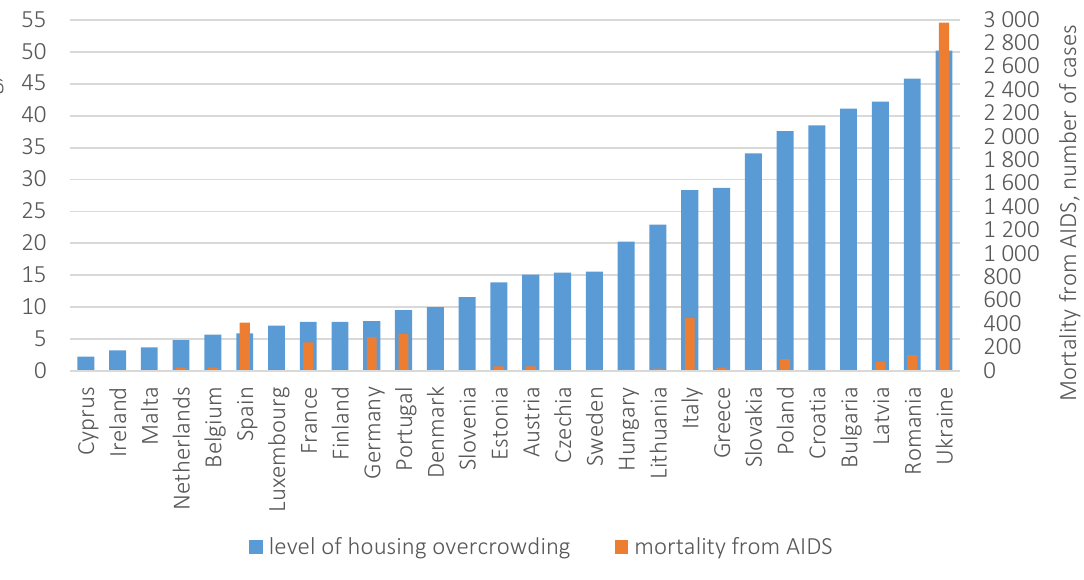
Figure 4. Comparative analysis of the EU countries and Ukraine in terms of housing overcrowding and AIDS mortality in